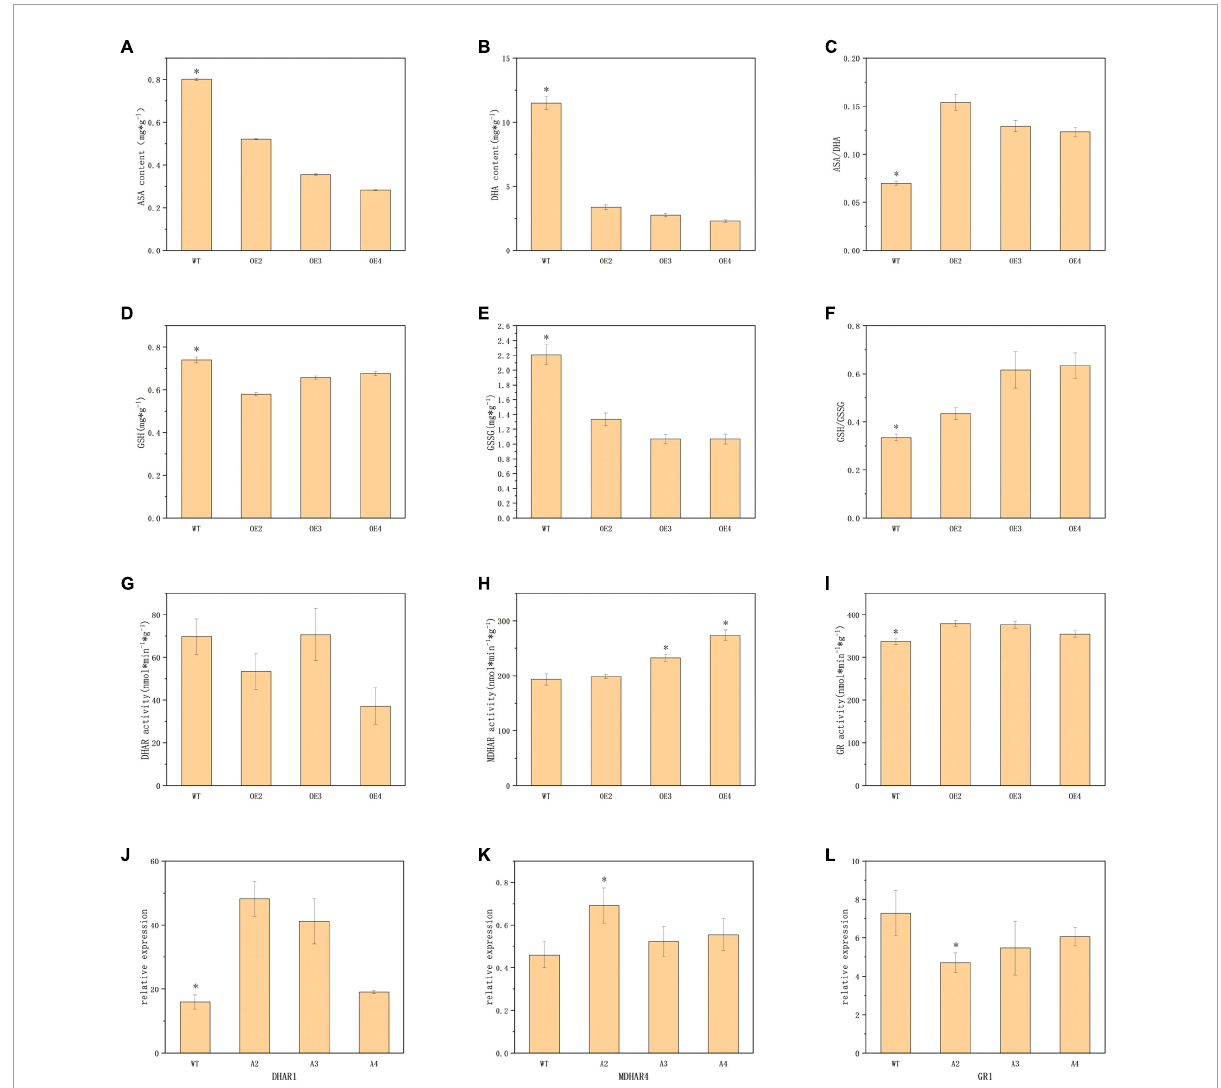
FIGURE4 Determination of indicators related to non-enzymatic antioxidant systems. Panels (A,B,D,E) represents the content of ASA, DHA, GSH, and GSSG in turn. Panel (C,F) represents the ASA/DHA and GSH/GSSG ratio, respectively. Panels (G–I) represents the activities of DHAR, MDHAR, and GR. Panels (J–L) represents the relative expression of DHAR1 , MDHAR4 , and GR1 . The values are means ± SD ( n = 3). ∗ , in graphs, indicates significant differences in the means at p < 0.05 between each level in transgenic lines and WT